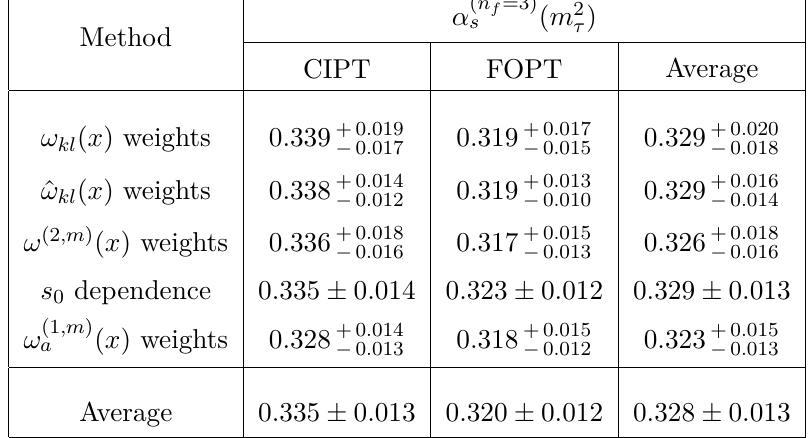
Table 1 . Determinations of α ( n f =3) s ( m 2